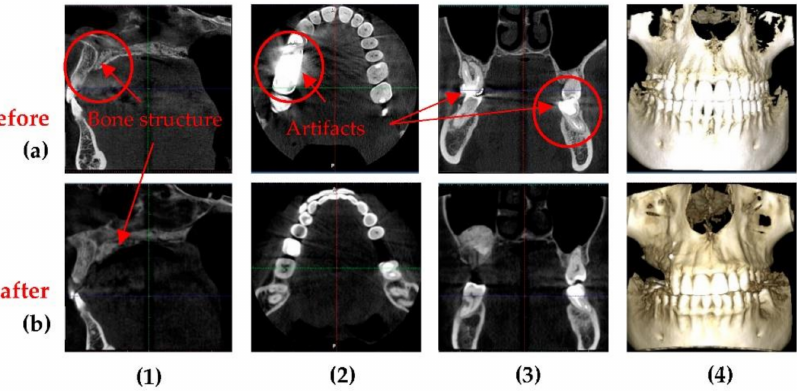
Figure 11. Panoramic radiographs performed on the same patient (F.C., male, 29 years old) ( a ) before and ( b ) after the optimization.